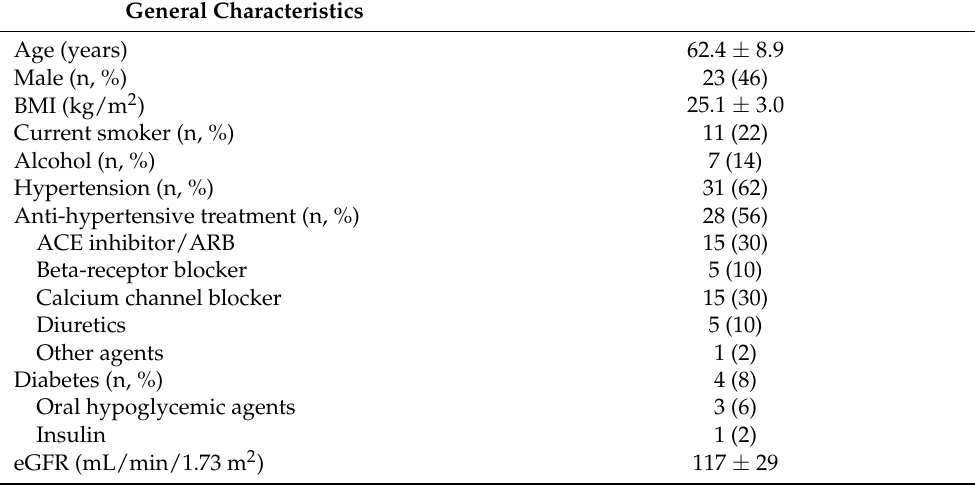
Table 1. Characteristics of